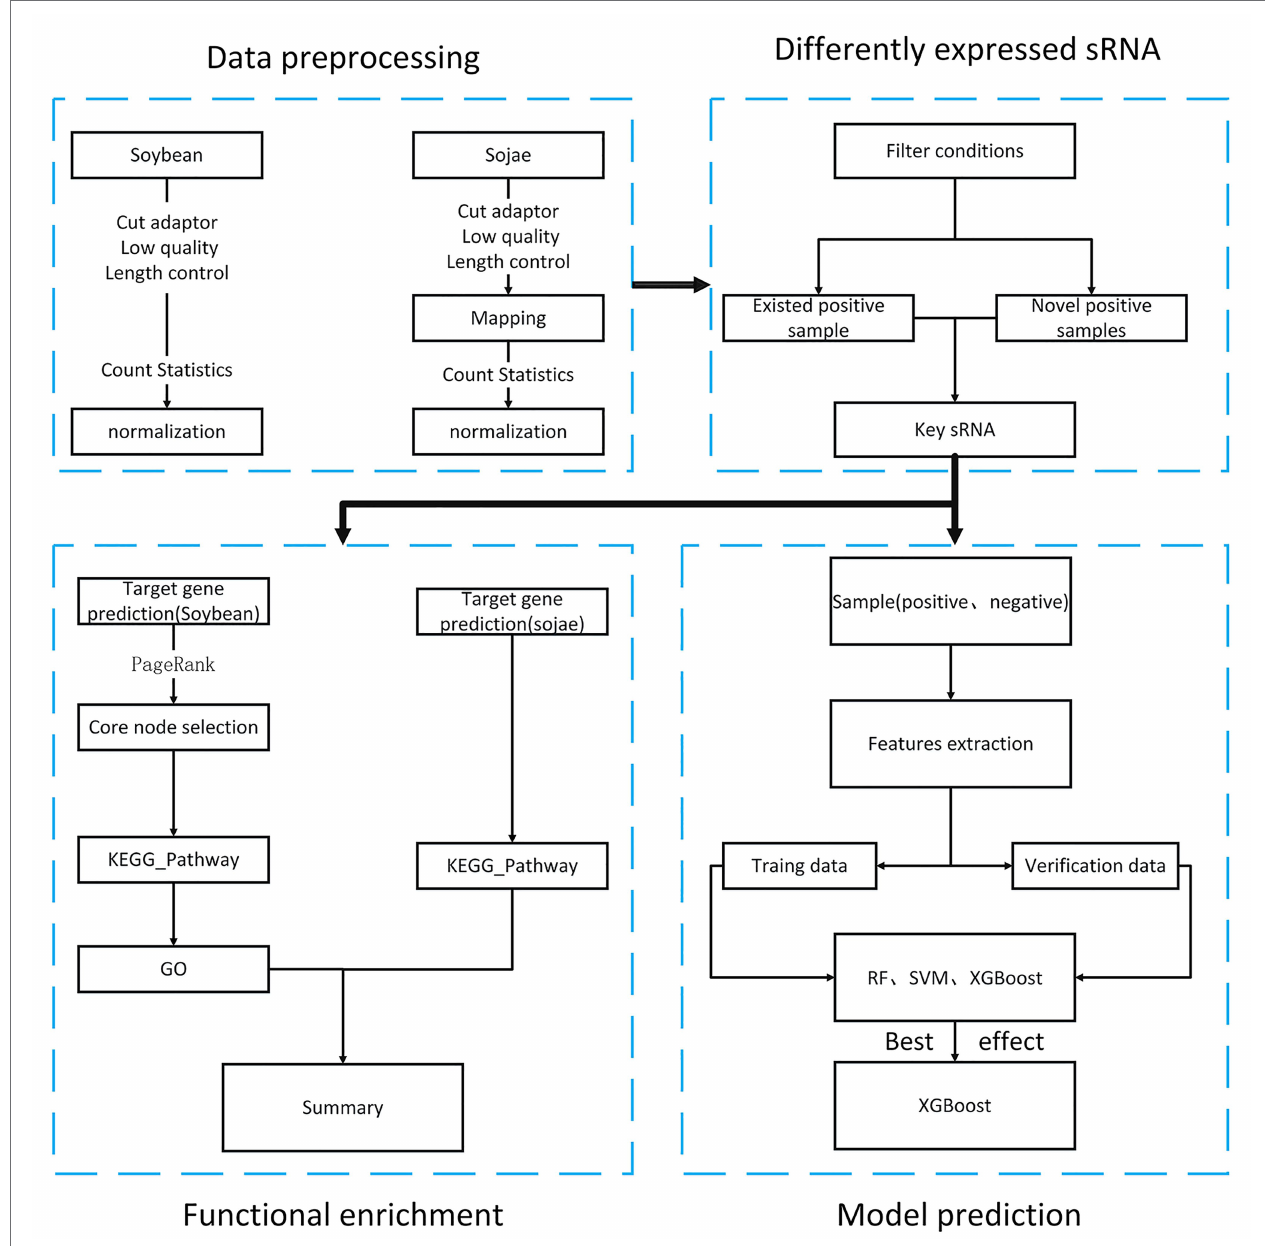
FIGURE 1 | Research flowchart of soybean resistance